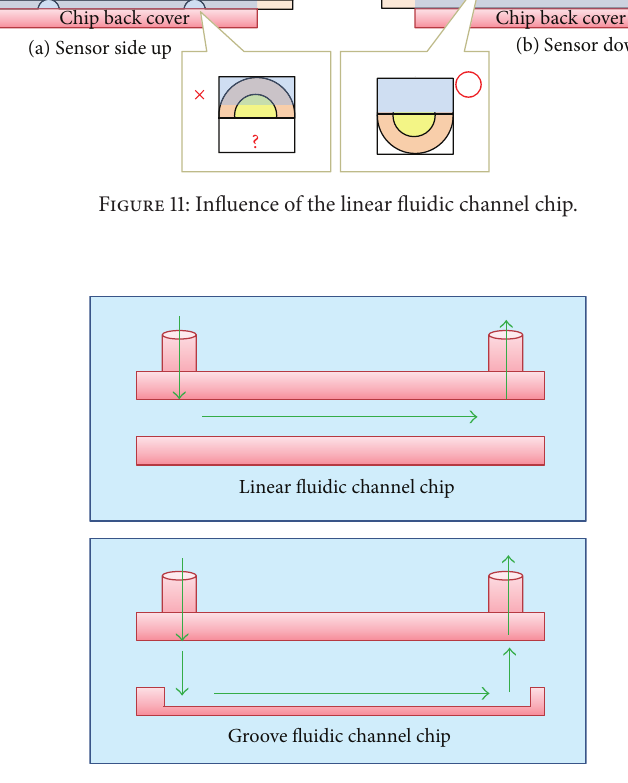
Figure 12: Linear and groove fluidic channel